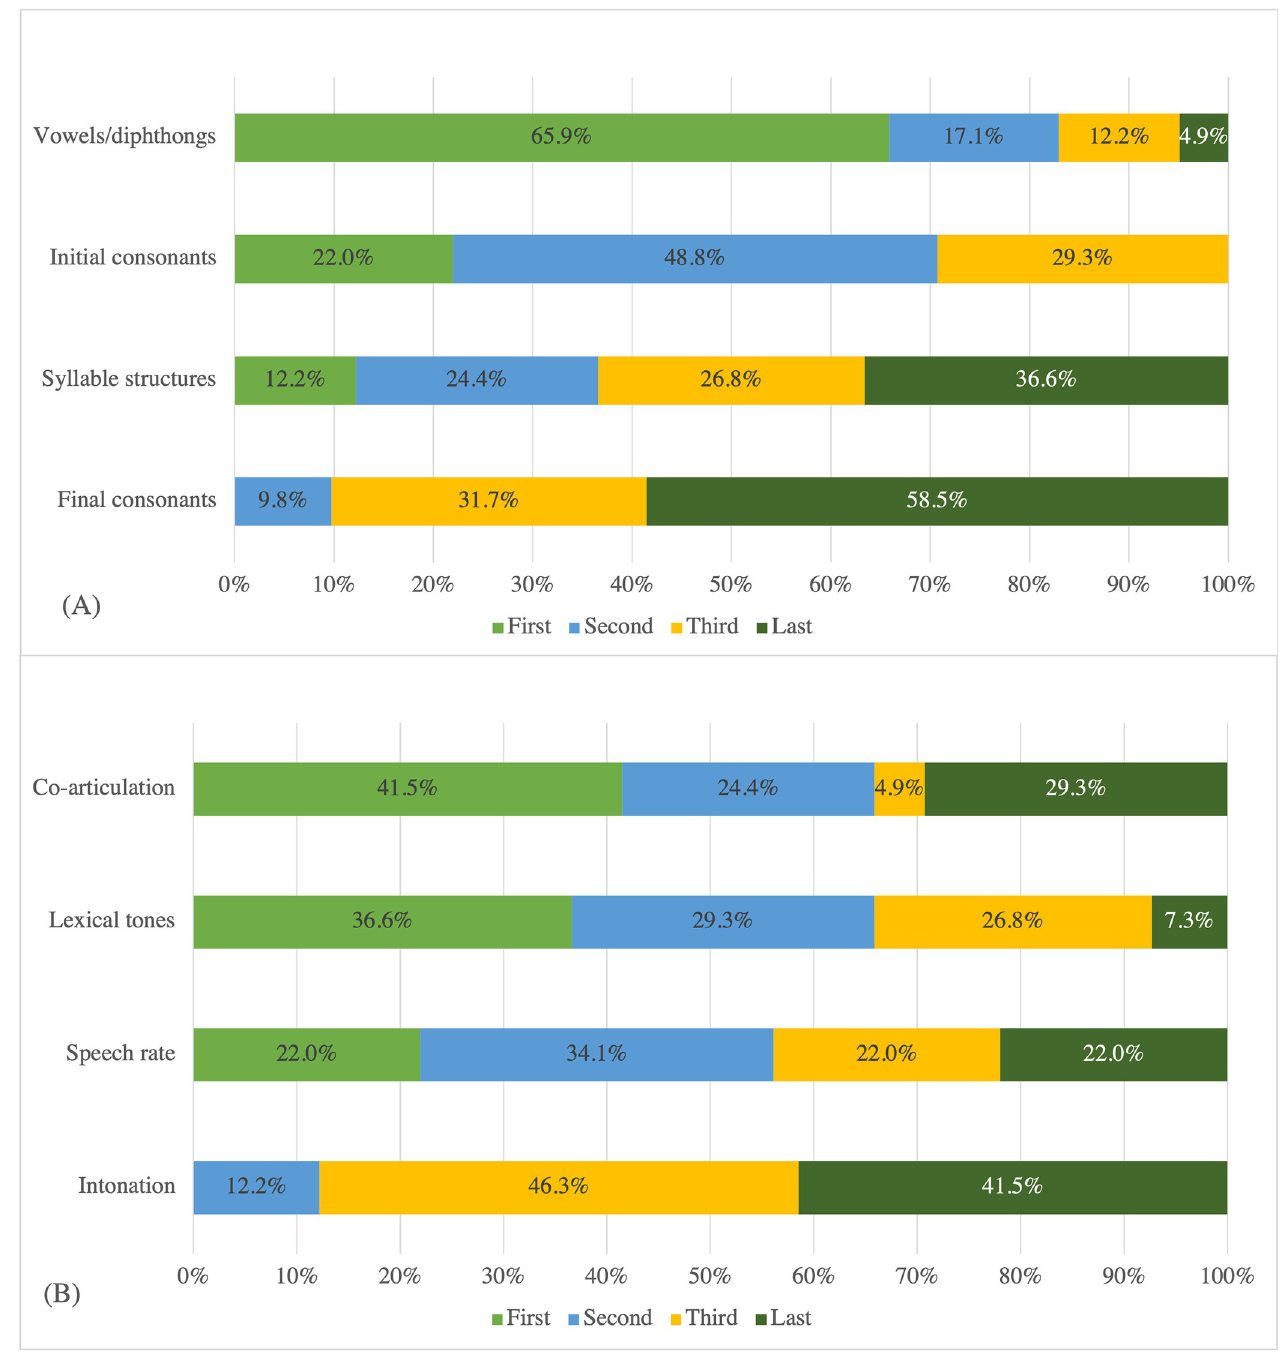
Fig 8. Distribution of treatment priorities for different types of segments and